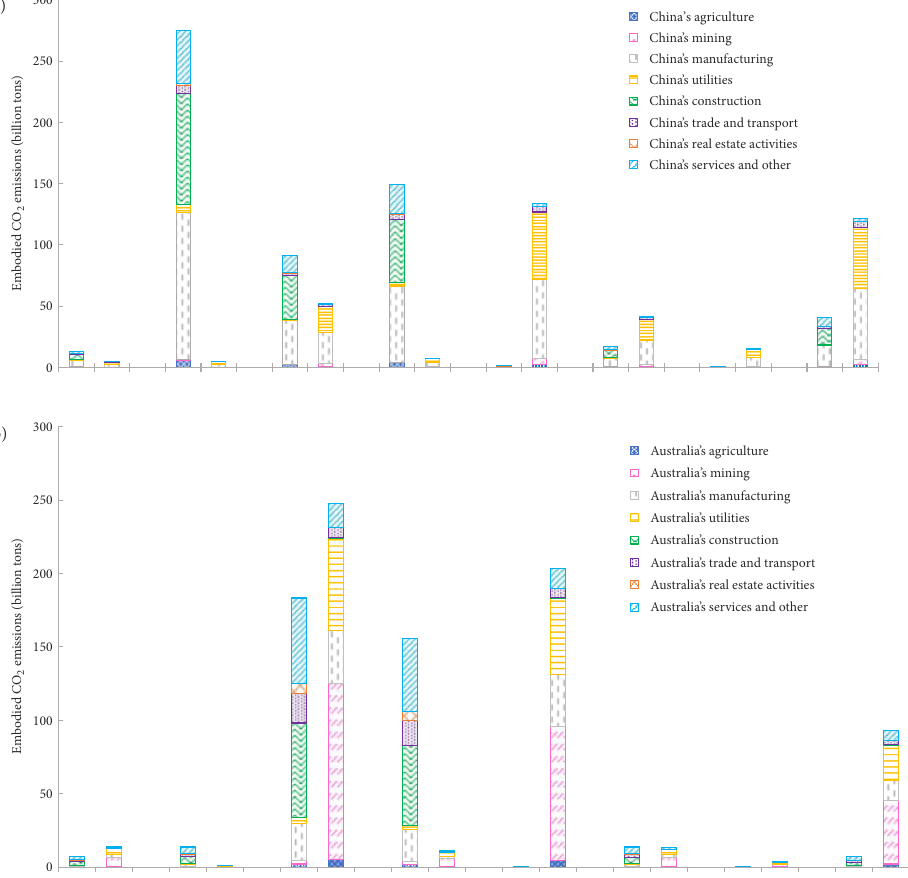
Figure 2. Embodied CO 2 flows in 2014 in: a – exports from and imports to Australia; b – exports from and imports to